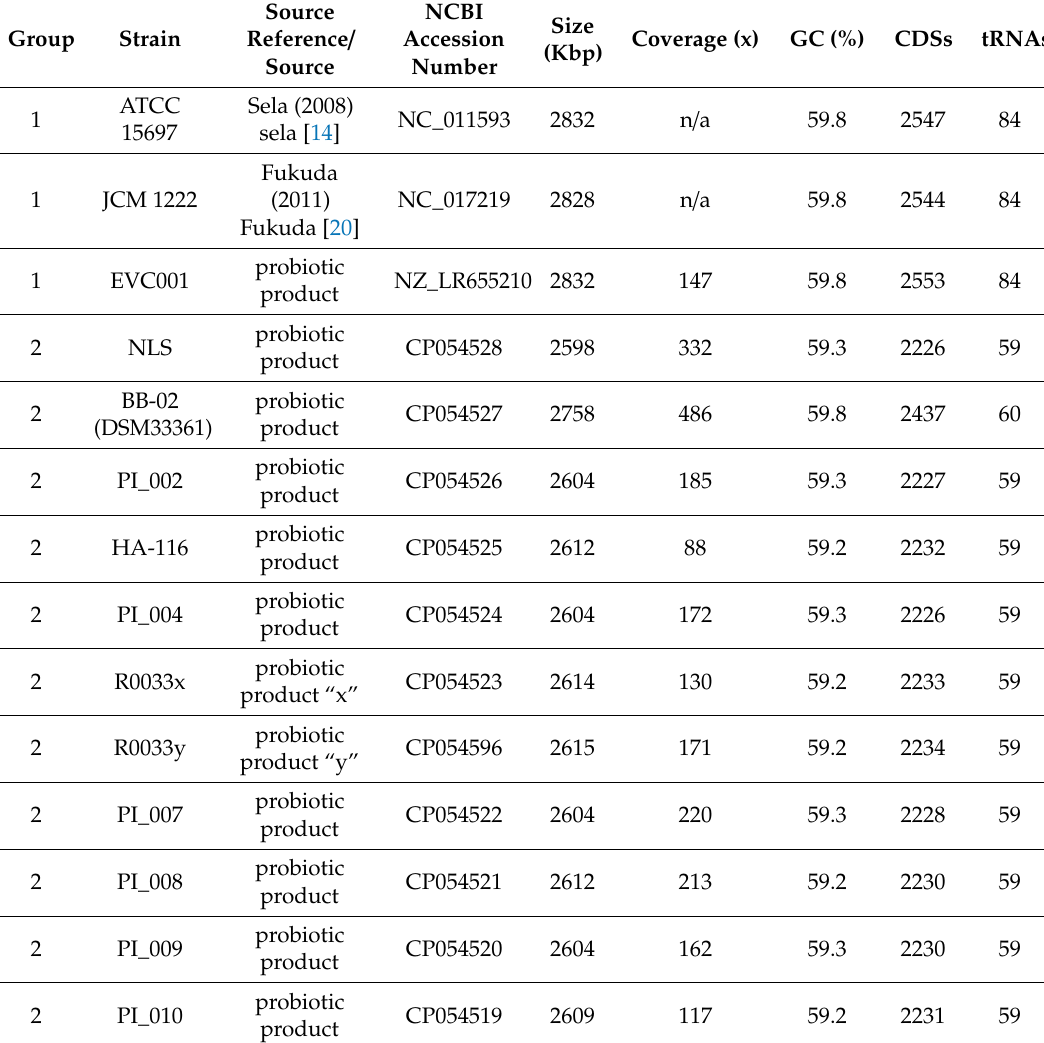
Table 1. General features of the bifidobacteria included in this